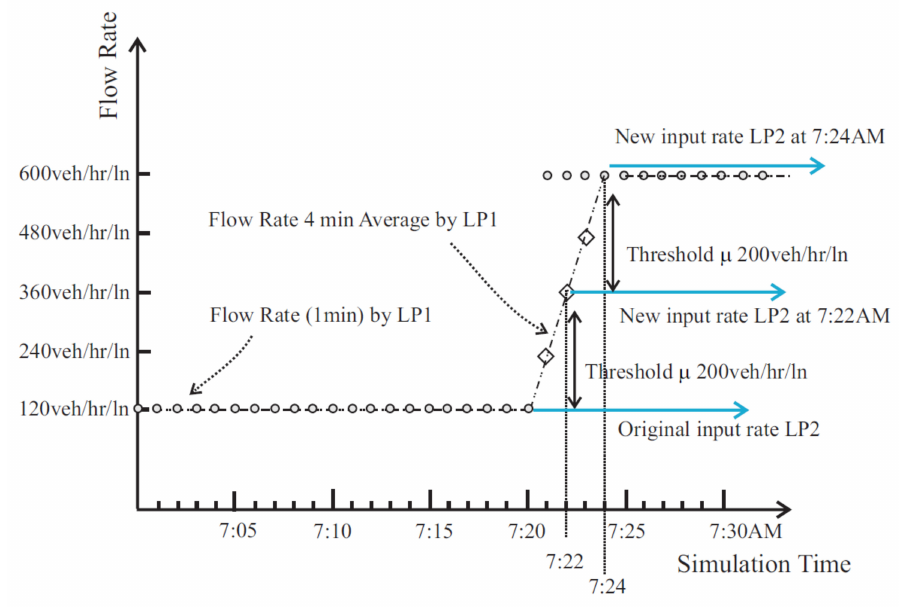
Figure 3. Flow rate diagram for ad hoc distributed